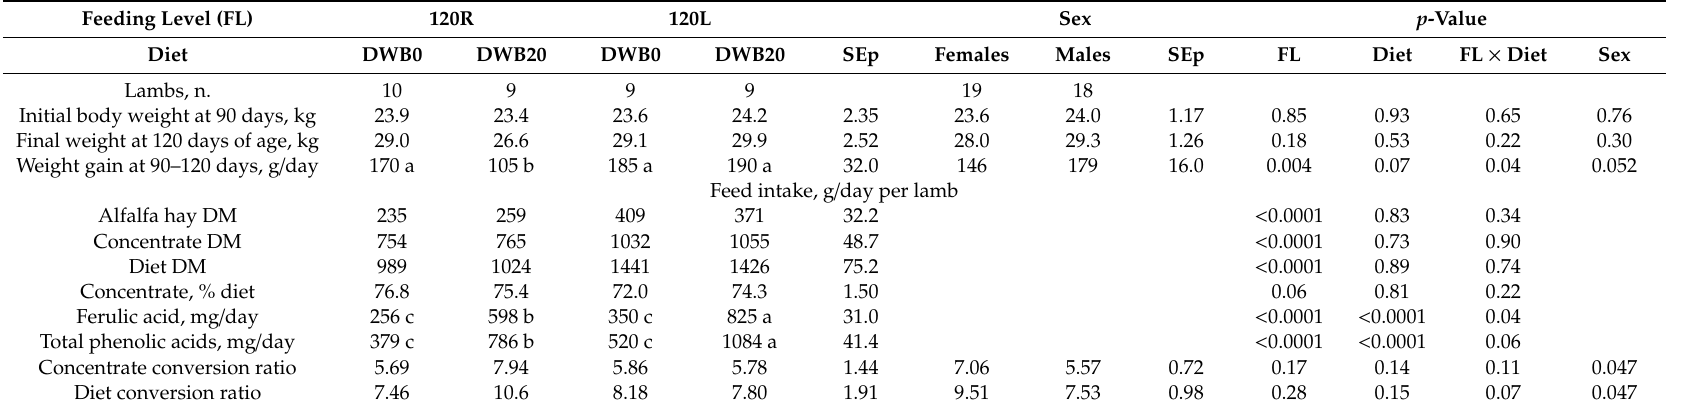
Table 3. Growth performance and feed intake of lambs from 90 to 120 days of